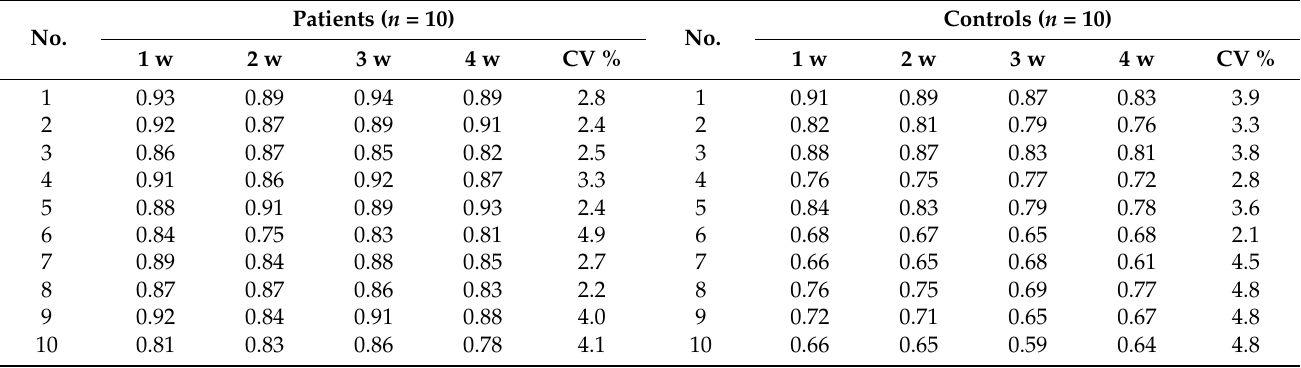
Figure 5. Correlation coefficients before and after meal of each group include DM patients and healthy controls, the Correlation refers to the correlation between blood and saliva glucose, and No. refers to the number of participants. Table 3. Weekly correlation coefficient between DM patients and control group within one